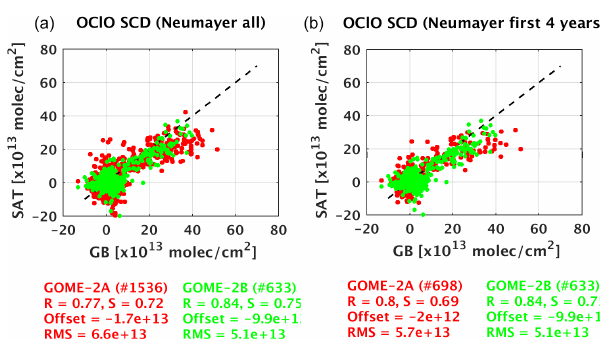
Figure 15. Scatter plot between daily GOME-2A (red) and GOME- 2B (green) GDP 4.8 satellite data and ground-based data at Neu- mayer station for all data (a) and the first 4 years of operation (b) of each satellite.